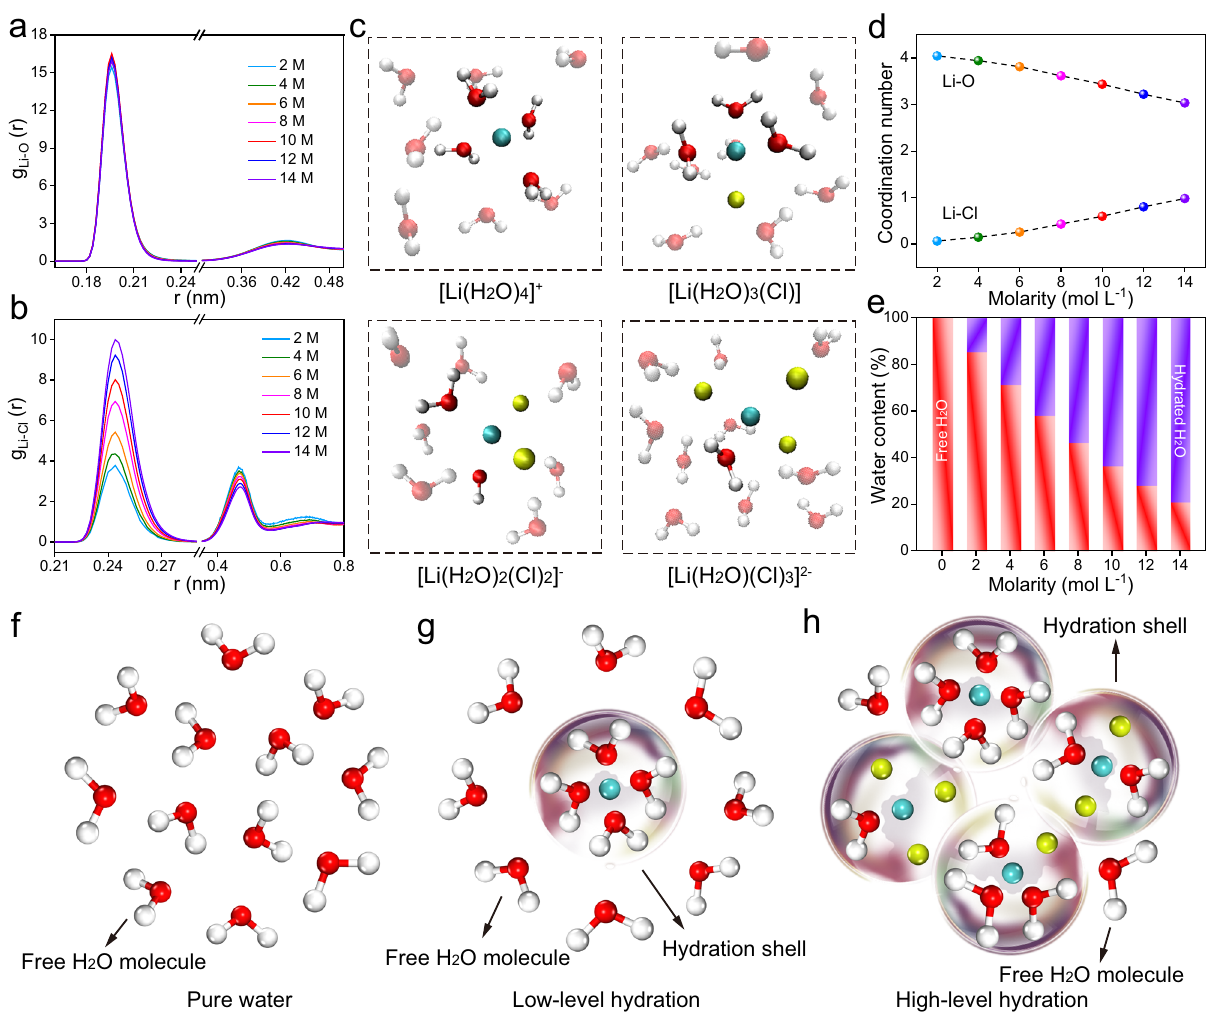
Fig. 1 Molecular dynamics simulations of the hydration system. Radial distribution function for a Li + -O and b Li + -Cl − interactions. c Representation of the four stable clusters for the LiCl coordination sphere. d Coordination number of Li + -O and Li + -Cl − as a function of LiCl concentration. e Water content in LiCl solutions of different concentrations. Illustration of the evolution of the hydration shell in f pure water, g a low-level hydration system, and h a high- level hydration system. The cyan, yellow, red, and white spheres represent Li, Cl, O, and H atoms,